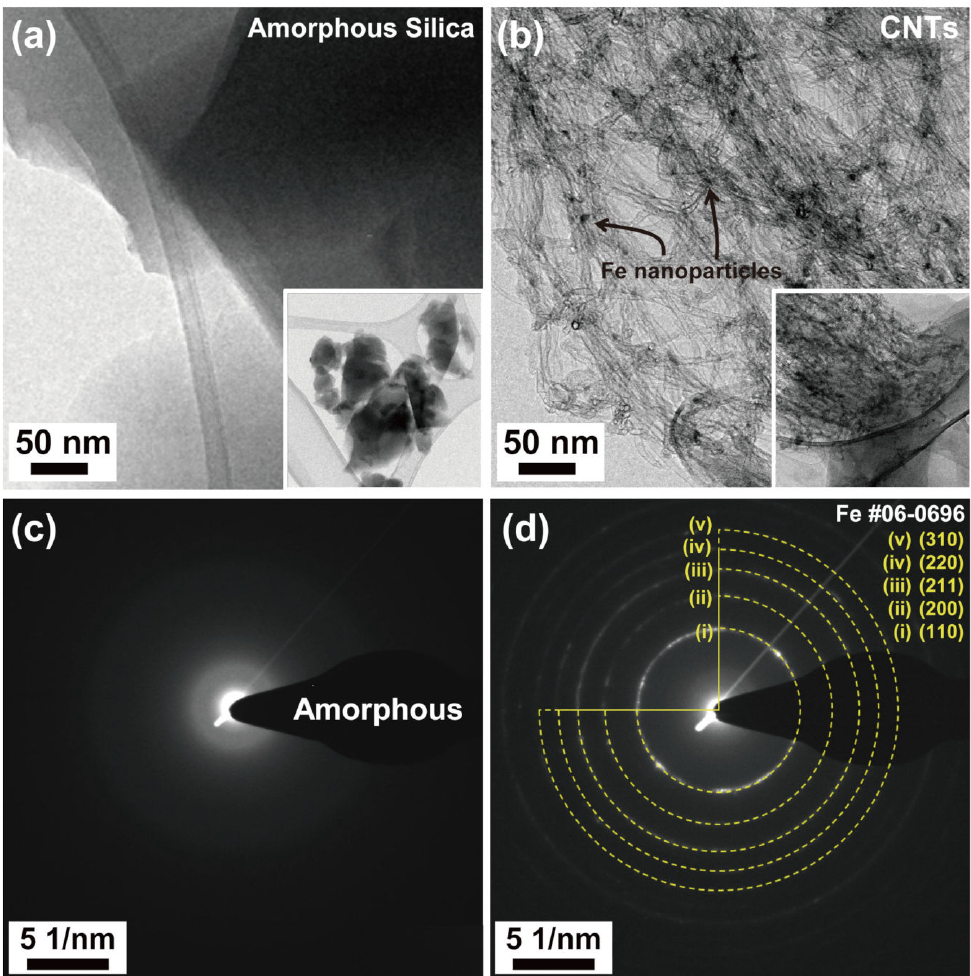
Figure 3. TEM images of the ( a ) P-QWF; ( b ) C-QWF and selected area electron di ff raction (SAED) pattern of the ( c ) P-QWF and ( d )